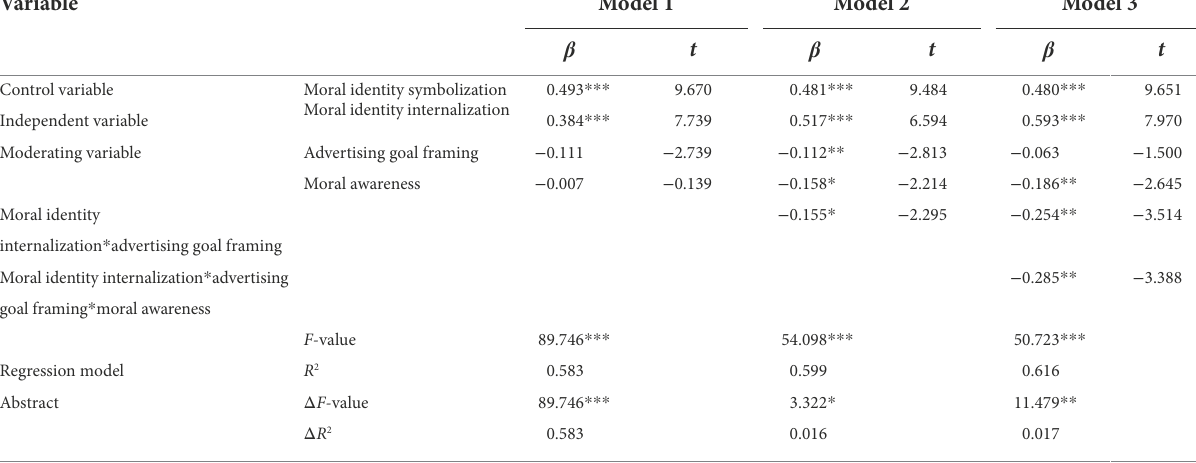
TABLE 2 Analysis of the moderating role of moral